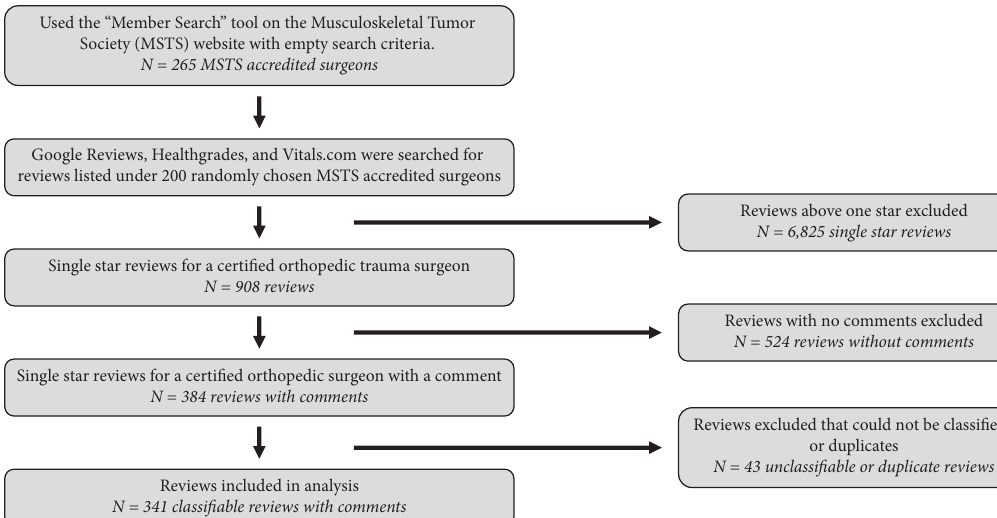
Figure 1: Flowchart of inclusion and exclusion criteria for this study.